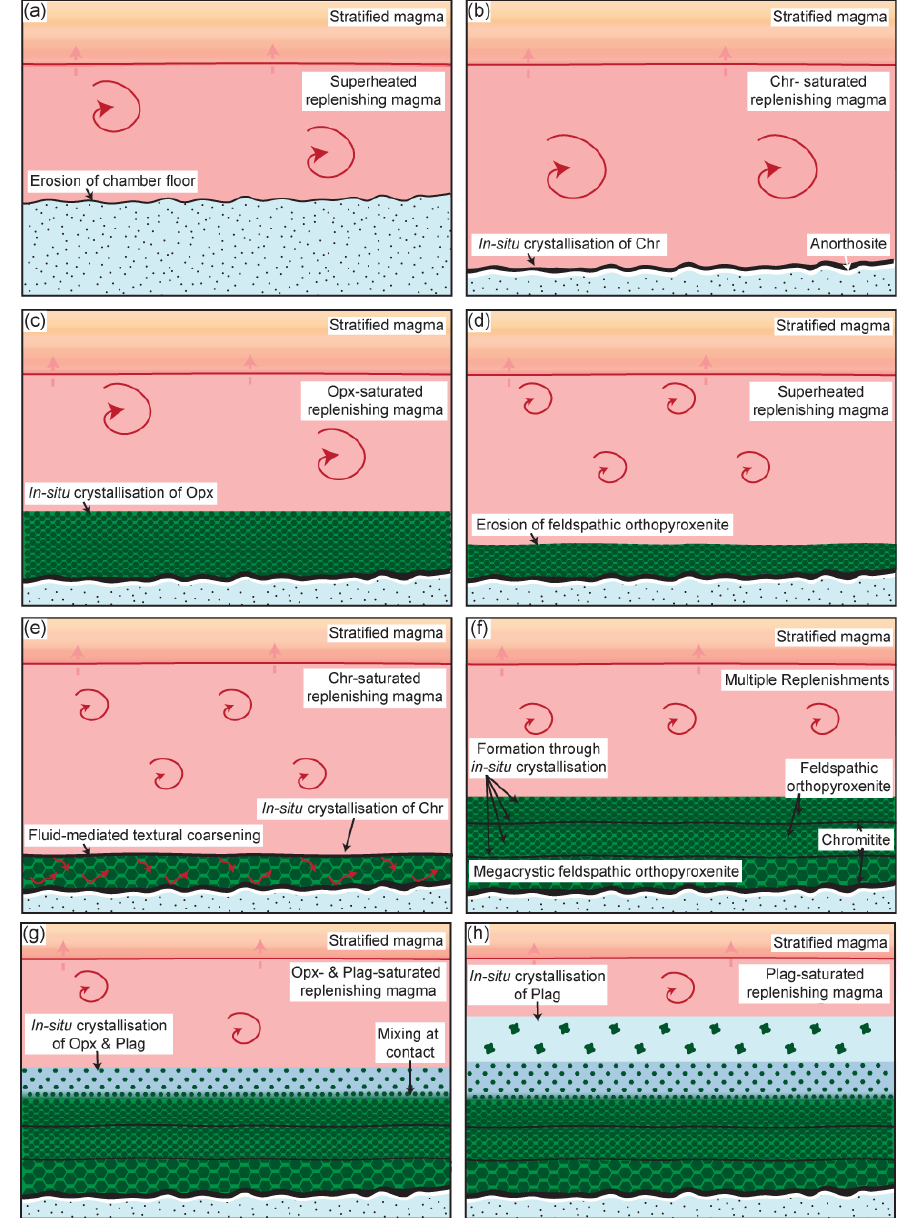
Figure 11. Model of processes forming the Merensky Unit: ( a ) Replenishment by a superheated melts results in erosion of the chamber floor; ( b ) Cr-spinel forms in situ from chromite-saturated magma; ( c ) Orthopyroxene forms in situ from orthopyroxene-saturated magma; ( d ) Further replenishment by superheated magma results in erosion; ( e ) Fluid-mediated textural coarsening develops the megacrystic feldspathic orthopyroxenite and Cr-spinel forms in situ from chrome-saturated magma; ( f ) Multiple replenishment events with associated erosion and subsequent in situ crystallisation develop the chromite-feldspathic orthopyroxenite sequence; ( g ) Leuconorite develops above a gradational boundary due to mixing combined with in situ crystallisation of orthopyroxene and plagioclase from orthopyroxene- and plagioclase-saturated magma; ( h ) In situ crystallisation of plagioclase from plagioclase-saturated magma develops the poikilitic anorthosite; Chr = Cr-spinel; Opx = orthopyroxene, Plag = plagioclase.